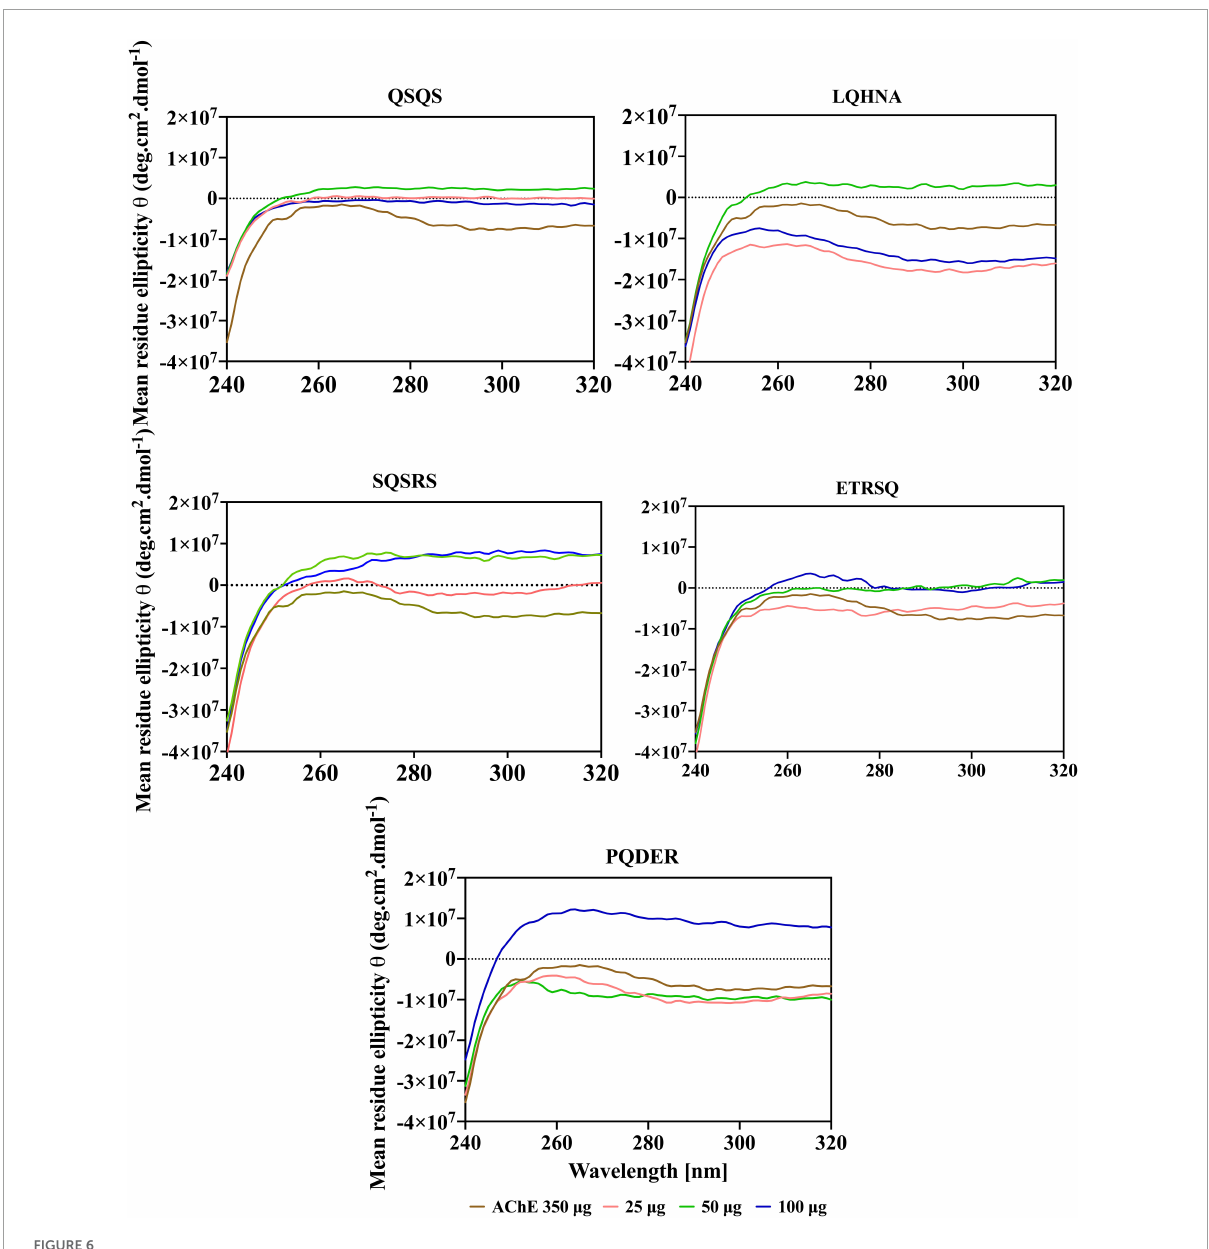
FIGURE6 Near-UV spectra of AChE in the presence of different concentrations of